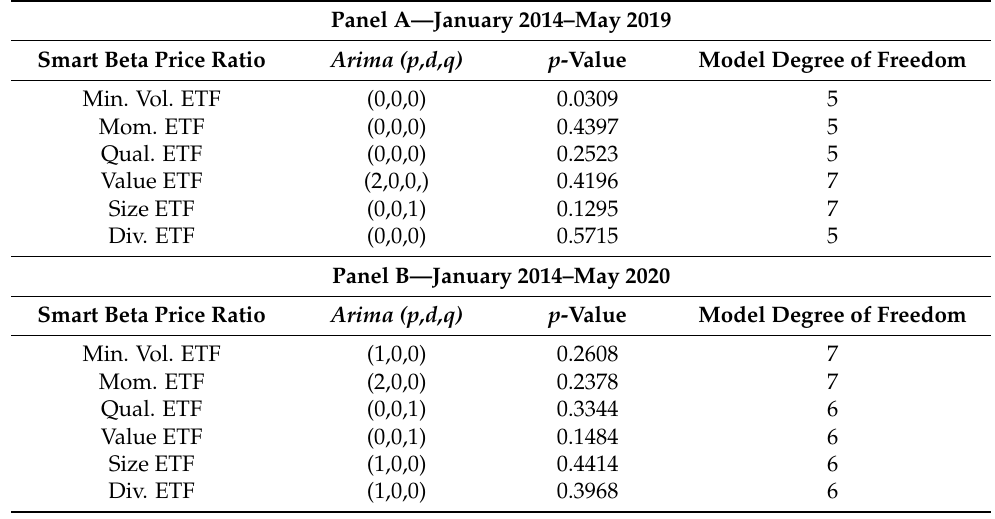
Table A5. Details on the results of auto.arima() corresponding to model (A1)–(A2) in Table A3.